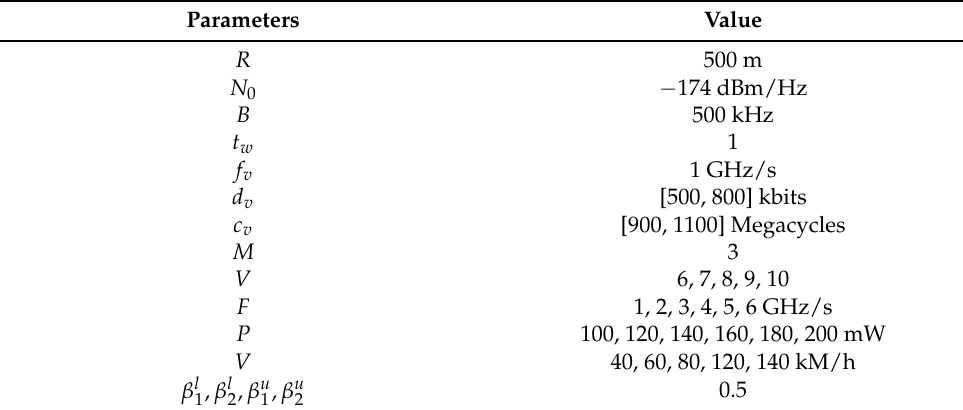
Table 3. Parameters of